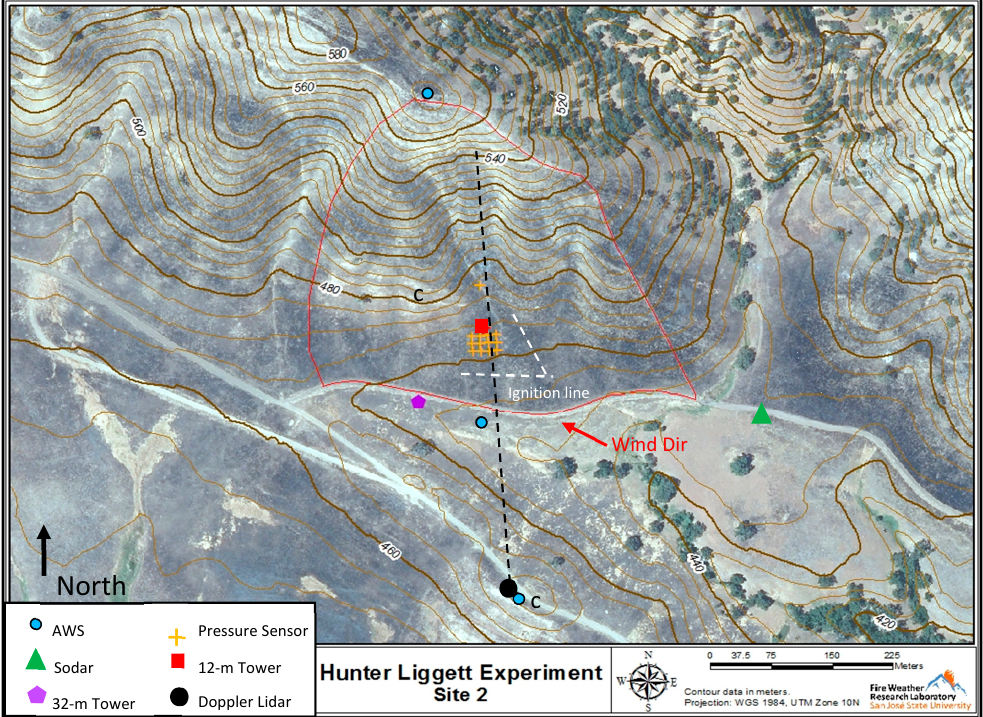
Figure 1. Topographic map showing experimental layout of the prescribed burn. Red outline shows the extent of the burn unit, while white dashed line shows ignition line. Black dashed line shows lidar line-of-sight scan path. Instruments are indicated by symbols at their precise locations. The red arrow near the ignition line indicates prevailing wind direction during ignition and the time-lapse cameras were located at point c.